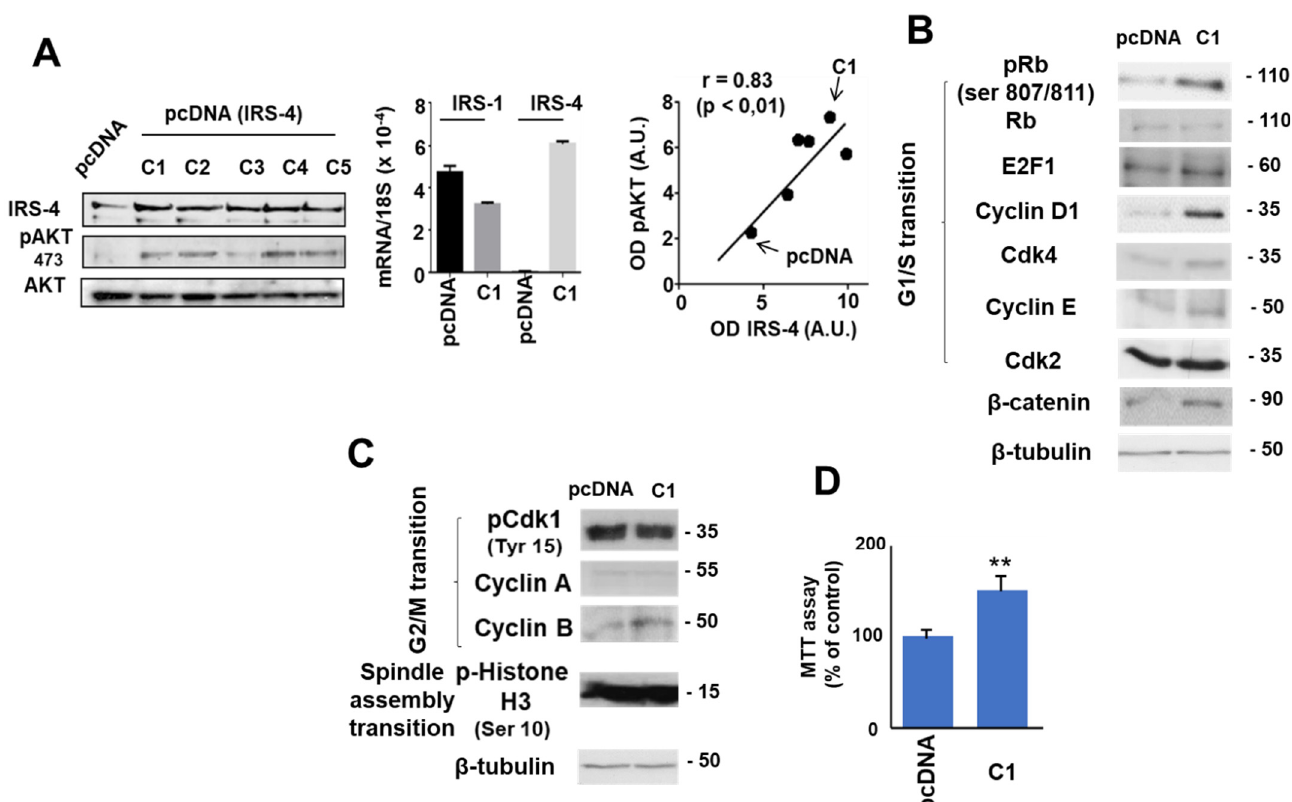
Figure 6. Immunoblot analyses of IRS-4 and other cell cycle regulatory proteins. ( A ). Western blot demonstrating IRS-4 pcDNA transfection of five cell lines (C1–C5). ( B ). Western blot of proteins involved in regulatory signaling pathways corresponding to G1/S transition in C1 and pcDNA colonies. ( C ). Western blot of proteins involved in regulatory signaling pathways corresponding to G2/M and spindle assembly transitions. ( D ). Cell proliferation compared to IRS-4 levels of C1 and pcDNA colonies. This experiment is the mean ± ESM of four performed in triplicate. The western blot experiments are representative of three–four others with similar results. ** p < 0.01.